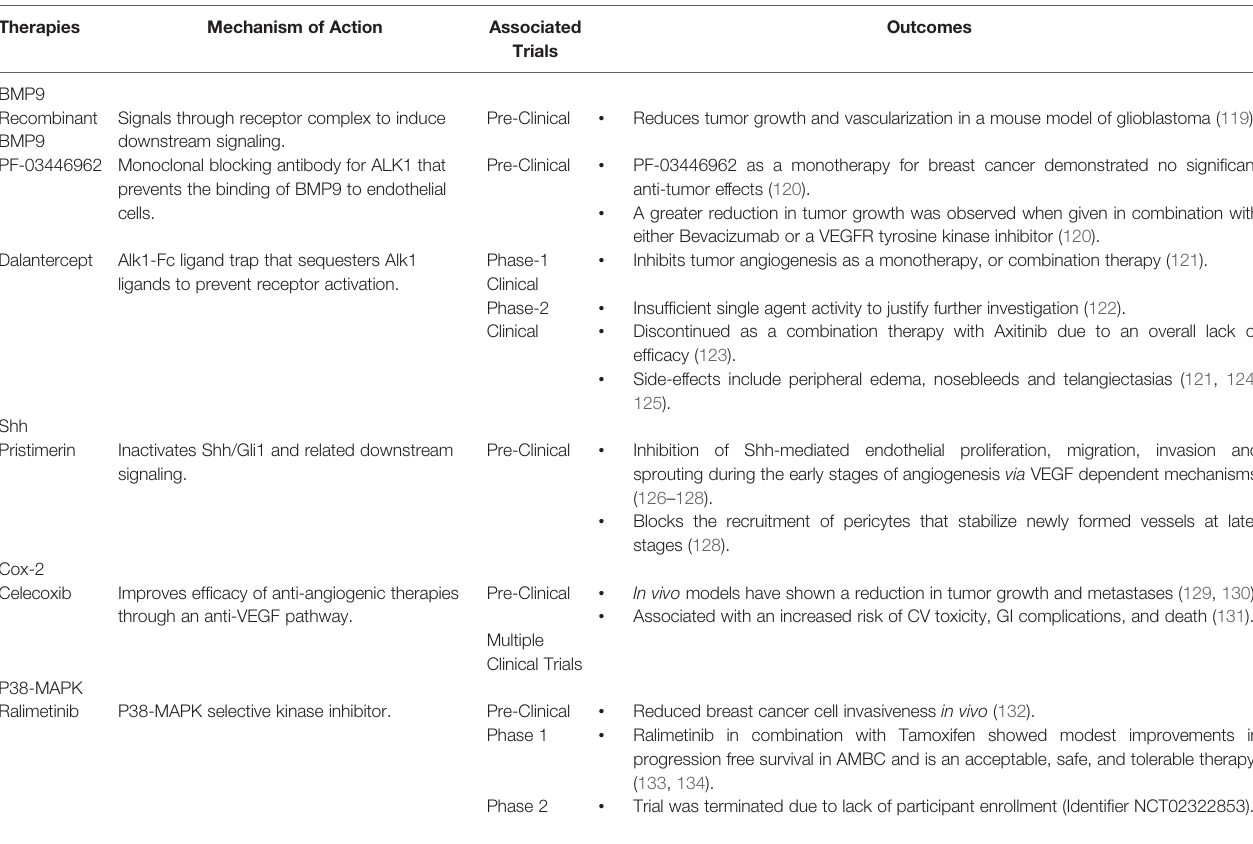
phosphorylation of the SMAD 1, 5 and 9 transcriptional TABLE 2 | Summary of Therapies Targeting Novel Tumor Angiogenesis Pathways in Breast Cancer. Therapies Mechanism of